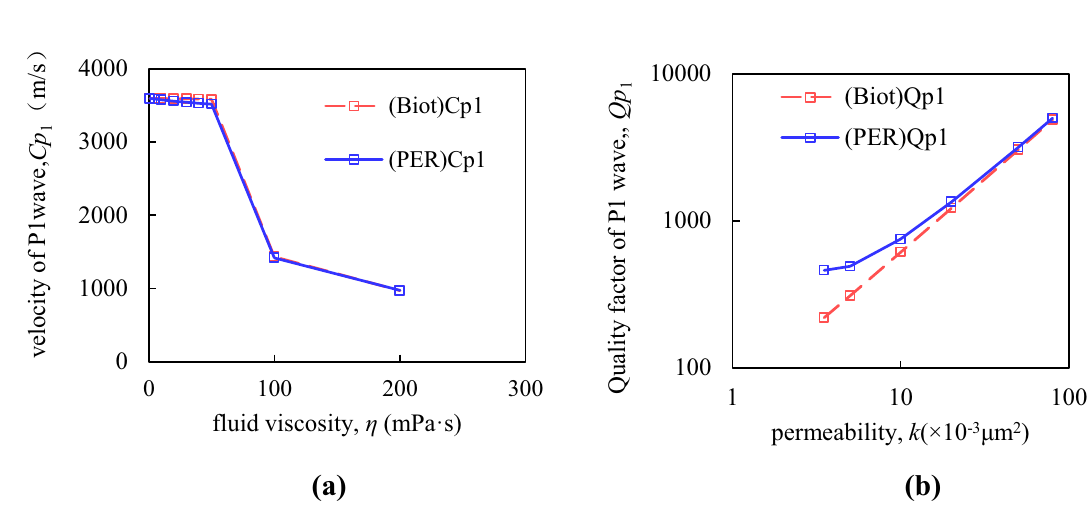
Fig. 6 Velocity and attenuation factor under different fluid